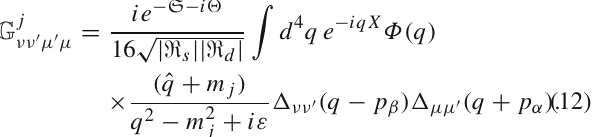
The tensor function G j νν (cid:15) μ (cid:15) μ accumulating the effects of all external wave packets has the